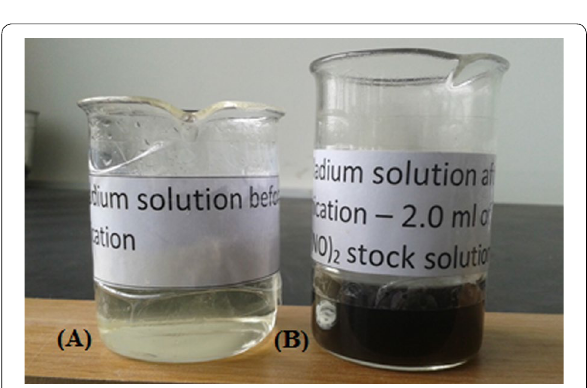
Fig. 5 Appearance of A the reaction mixture before the sonication process started and B the reaction mixture after the sonication process is